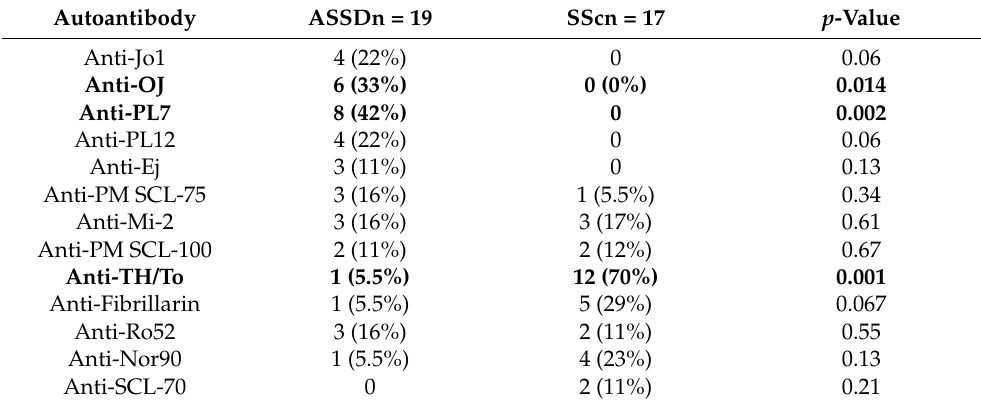
Table 2. Autoantibodies profile of recruited